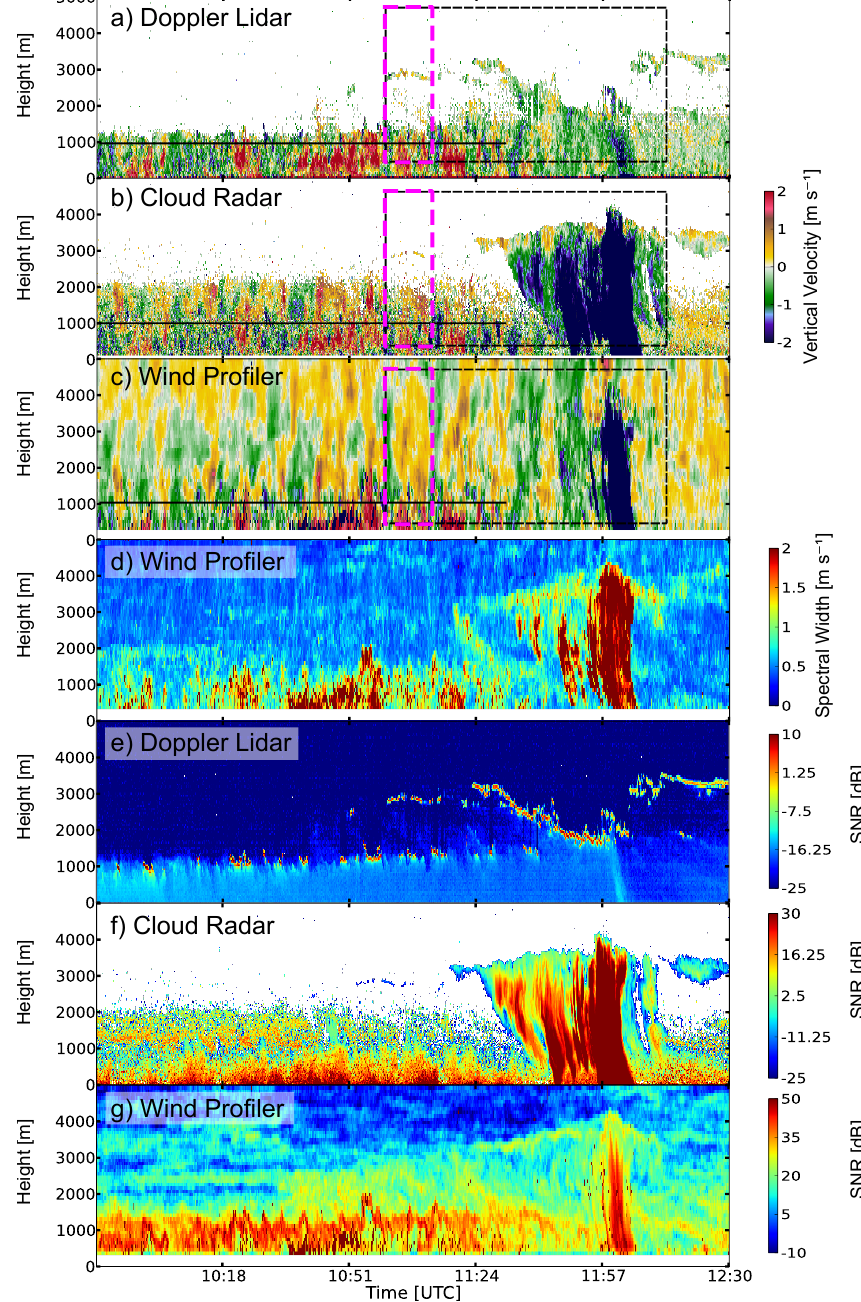
Figure 3. The combined measurements of Doppler lidar (a and e) , cloud radar ( b and f ) and wind profiler (c , d and g) from 30 July 2013 are shown. Vertical velocities (a–c) and signal strenght (e–g) are shown for all instruments. For the wind profiler, additionally the width of the spectral peak is shown in (d) .